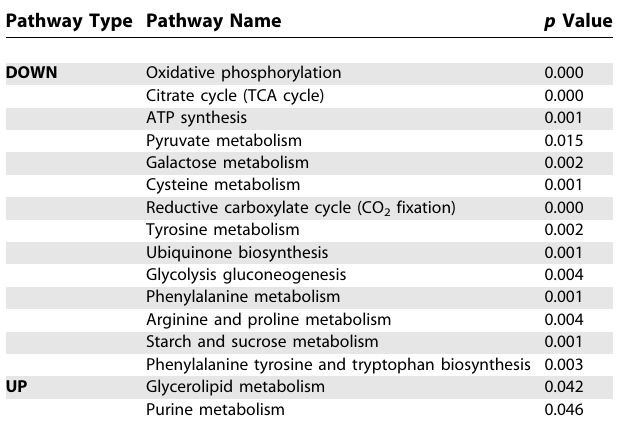
Table 2. Major KEGG Pathways Are Changed in PGC1 b KO Mouse BAT